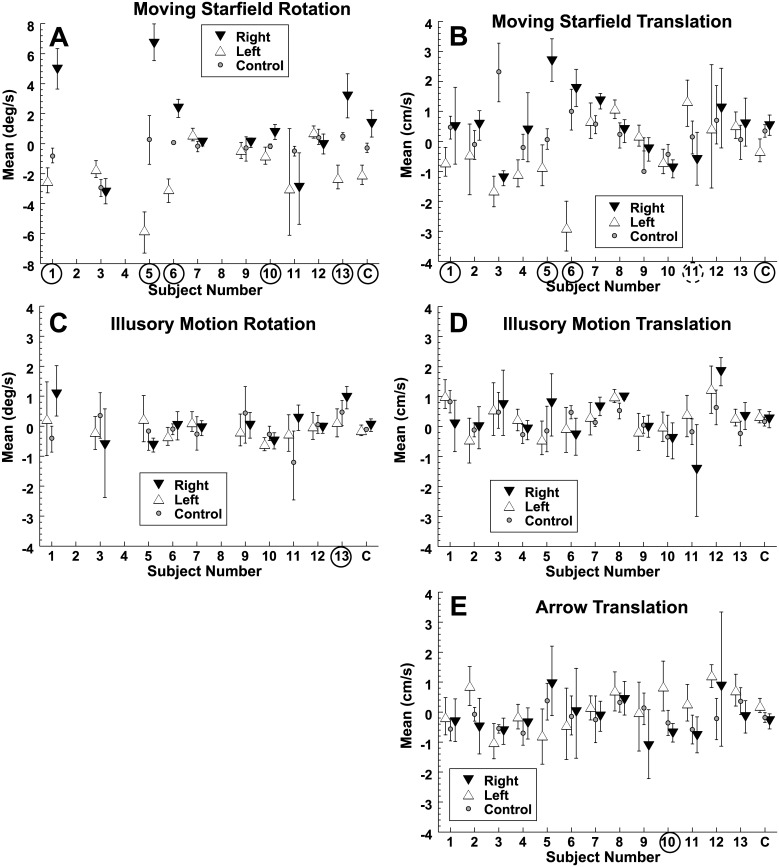
The effect of visual stimuli on inertial motion perception.In each case a small circle represents the control condition. Filled downward pointing triangles represent rightward visual motion (A,B), illusory motion (C,D), or a rightward pointing arrow (E). Open upward pointing triangles represent analogous leftward motion. Error bars represent the 95% confidence interval. The scale was expanded in panel A due to the larger effects in this condition. Subjects numbers are circled if there was a significant effect, dashed circles represent a significant effect in the direction opposite of expected. The furthest right column, (C) represents the combined or averaged response across subjects.